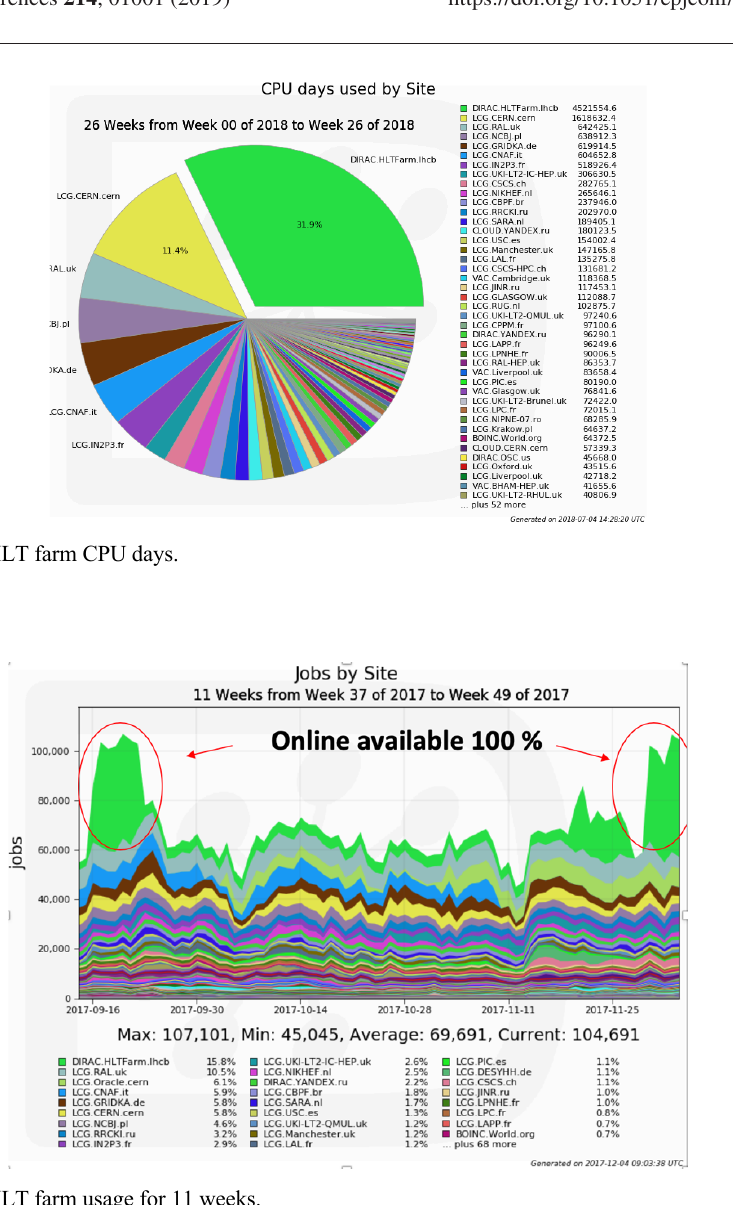
Figure 8. HLT farm usage for 11 Figure 6. Switch activity in the HLT farm.